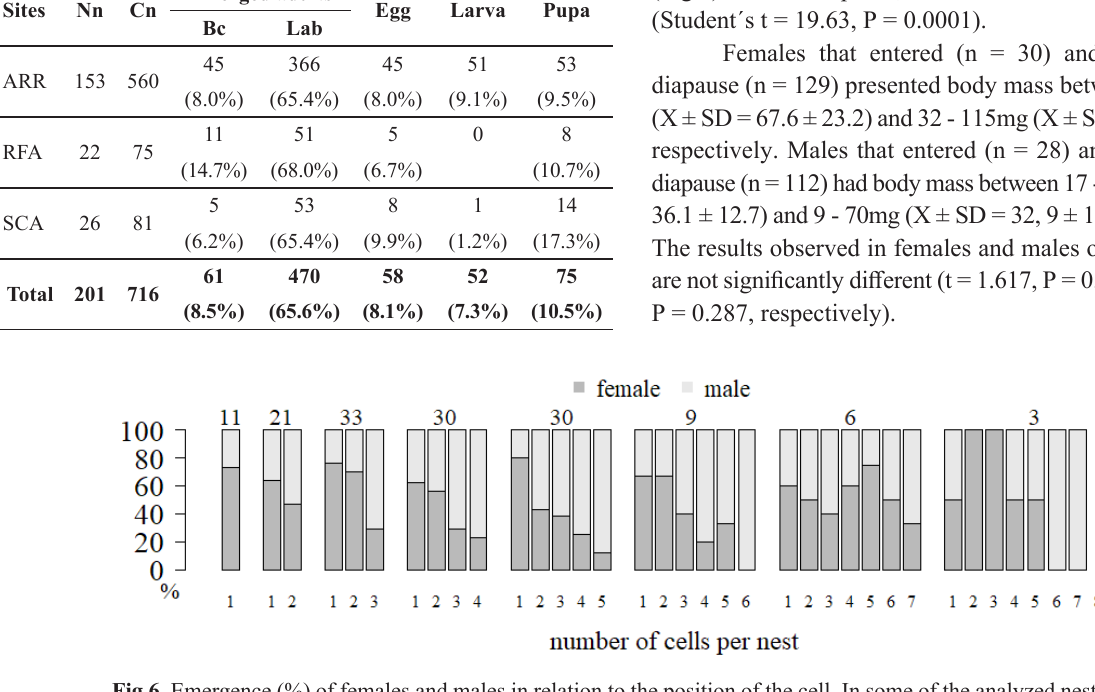
Fig 6 . Emergence (%) of females and males in relation to the position of the cell. In some of the analyzed nests, one or more individuals died before emergency.